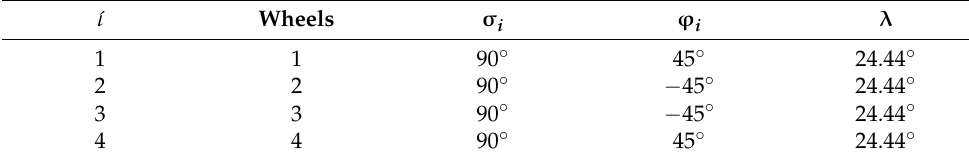
Table 2. Climbing Robot